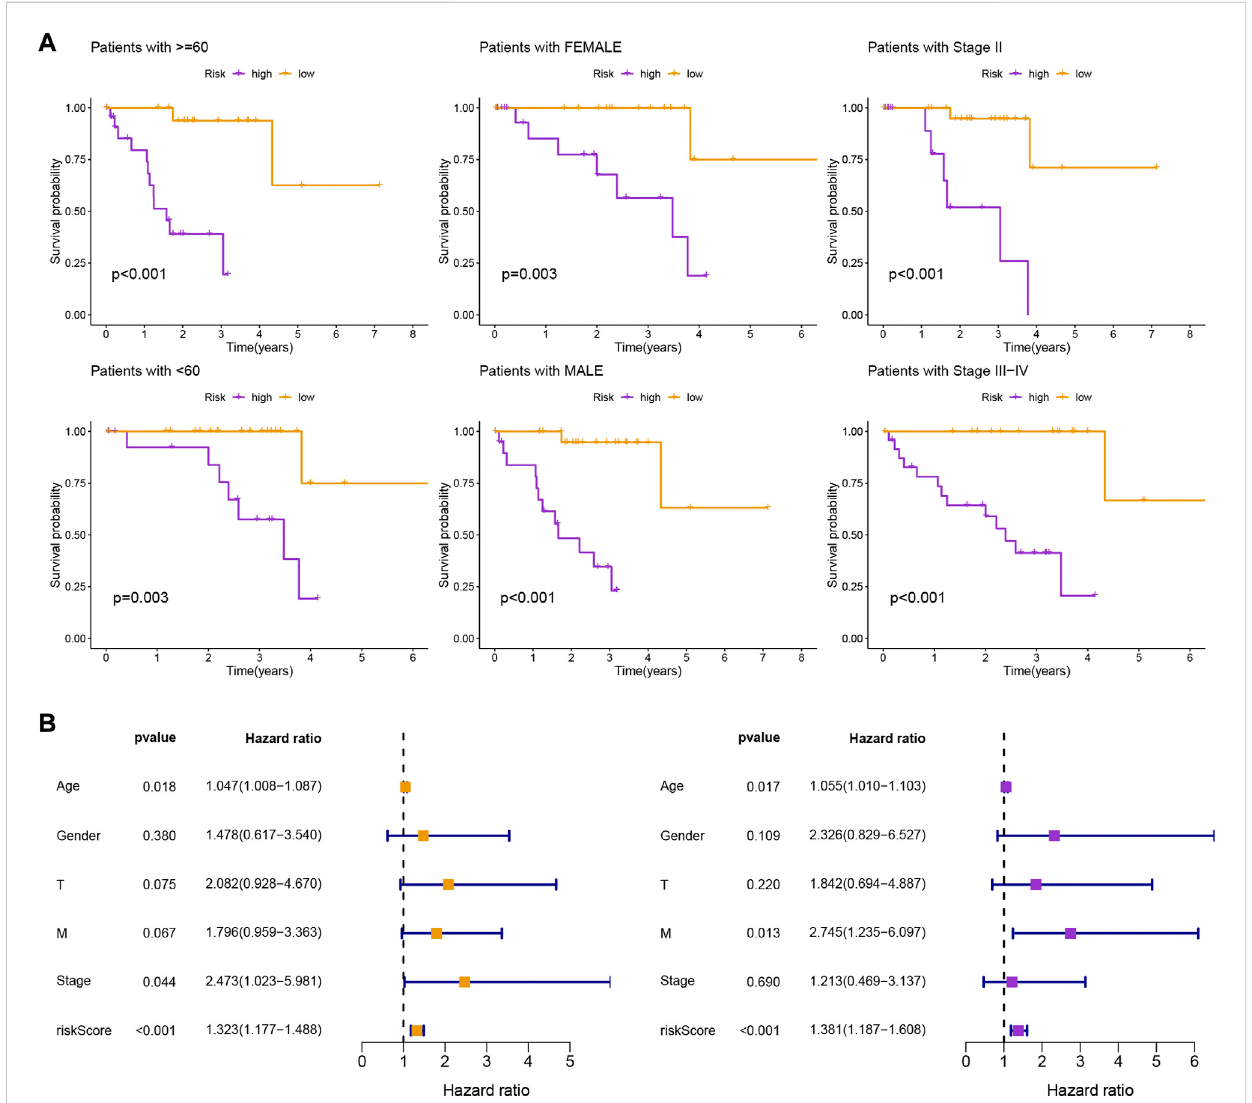
FIGURE 2 (A) Kaplan-Meier survival curves of uveal melanoma patients in different clinical groupings (I-IV) based on high and low risk scores derived from the gene expression signature. (B) Kaplan-Meier survival curves of uveal melanoma patients strati fi ed by high and low risk scores regardless of other clinical factors, showing that the risk score is a robust prognostic factor that can be used to stratify patients into different risk